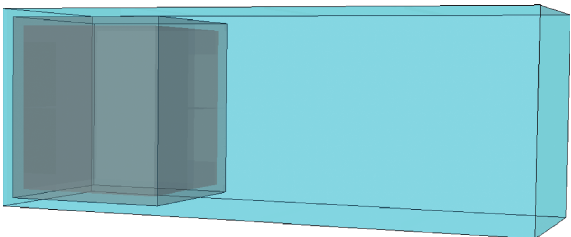
Figure 3: Model for the CEL